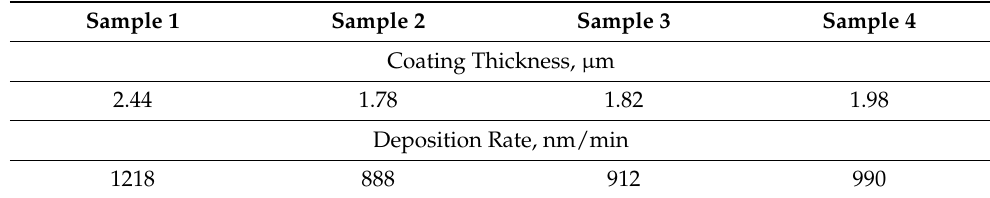
Table 3. Coating thickness and deposition rates.